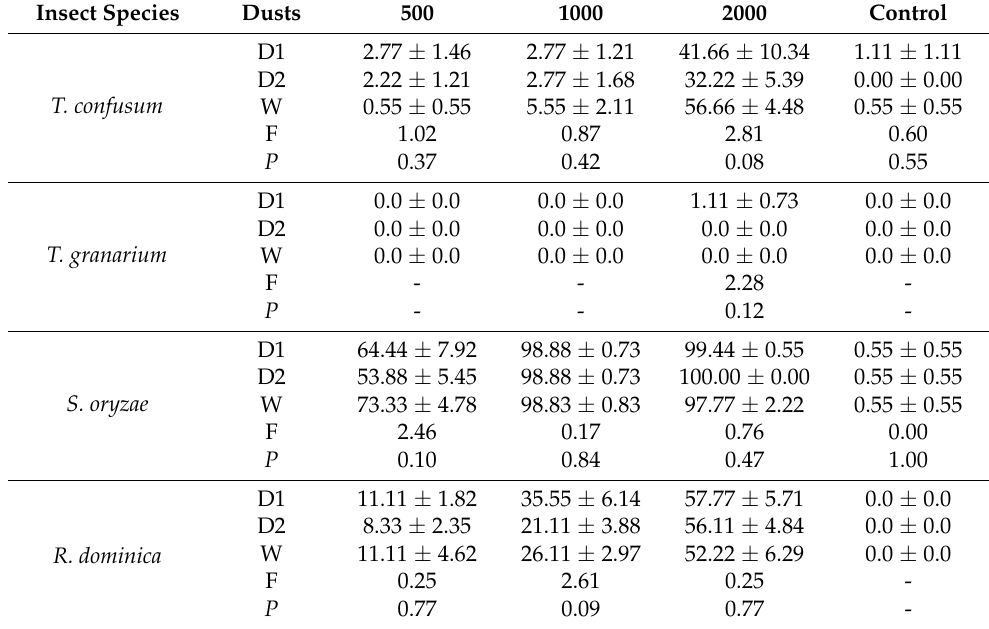
Table 4. Mean mortality (% ± SE) of Tribolium confusum , Sitophilus oryzae , Rhyzopertha dominica adults and Trogoderma granarium larvae after exposure to three different dust formulations (D1, D2, and W) applied at four concentration rates (500, 1000, 2000 ppm, and control) for Day 3 (in all cases df = 2.26). Insect